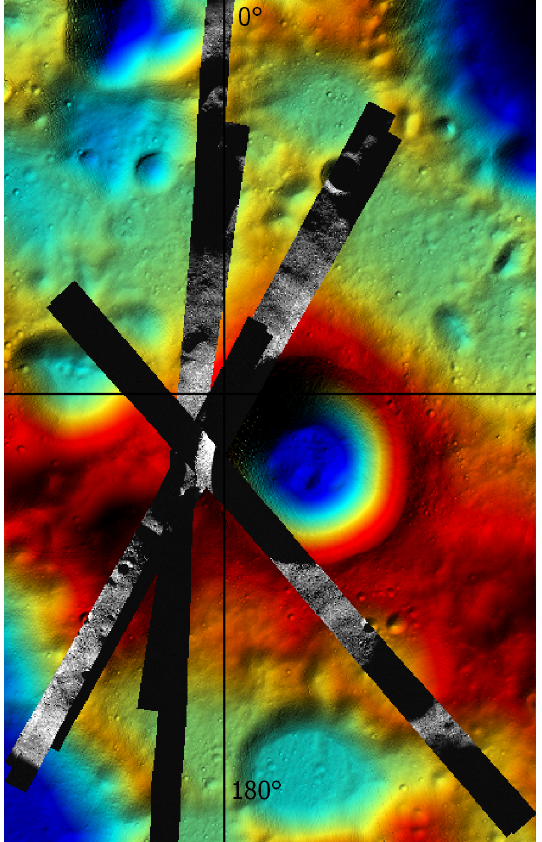
Figure 2. LROC NAC stereo pairs at SR1